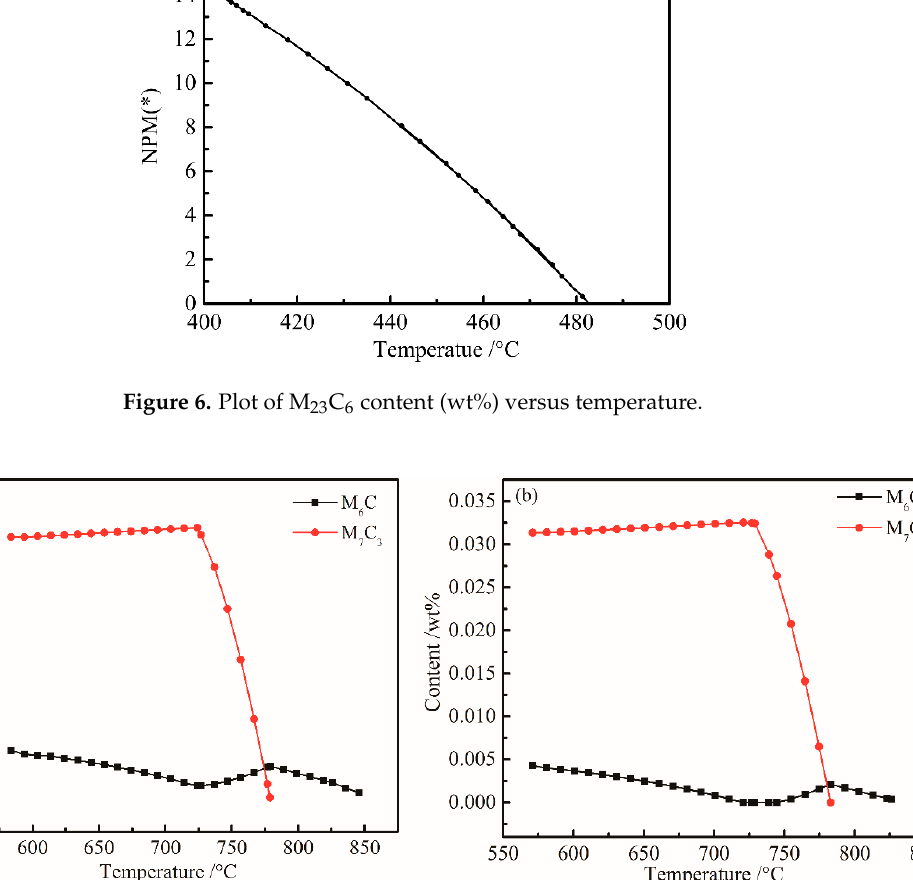
Figure 7. Plots of M 6 C and M 7 C 3 content (wt%) of versus temperature. ( a ) Original; ( b ) Optimized.